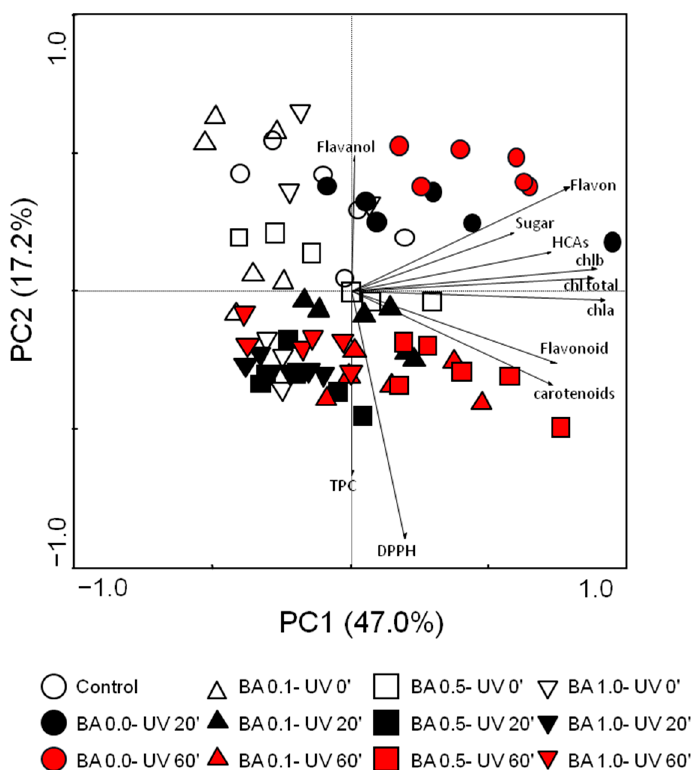
Figure 4. Principal component analysis based on the correlation matrix of the studied biochemical parameters. The untreated UV-C data are represented by unfilled symbols. Flavon represents the flavones and flavonols contents. The BA concentrations in the figure legend are expressed in mg L − 1 . PC1, principal component 1; PC2, principal component 2.